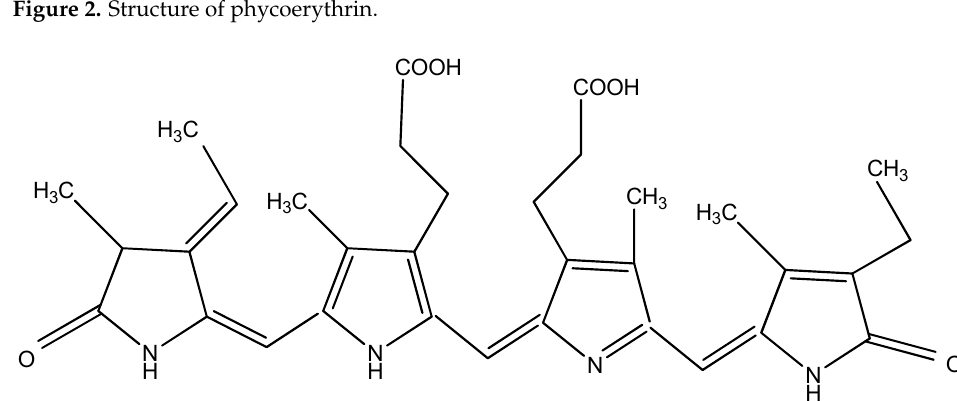
Figure 3. Structure of phycocyanin.